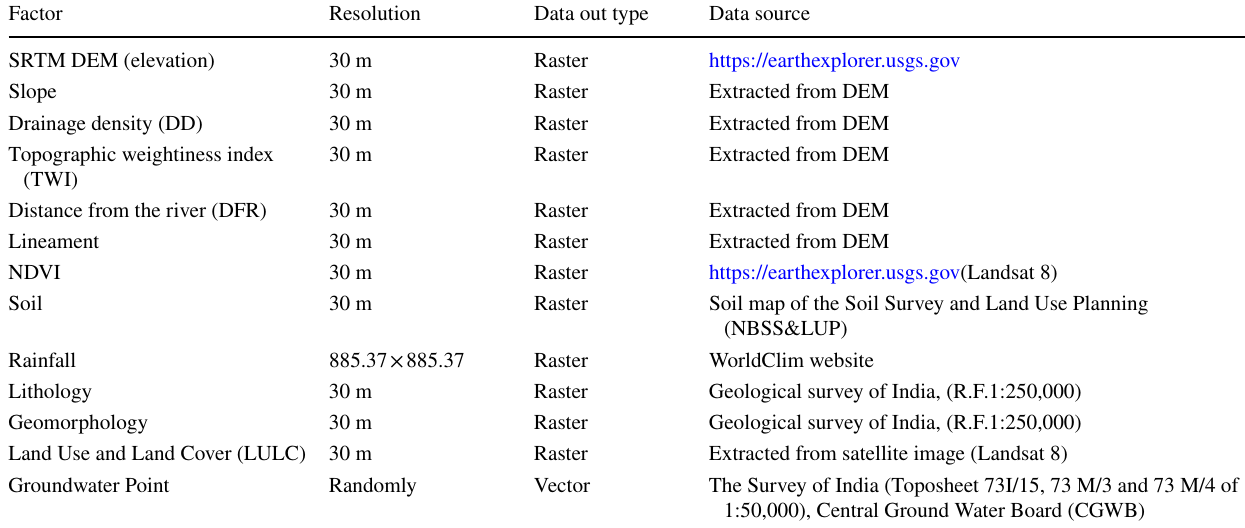
Table 1 Data sources and type of data required in the